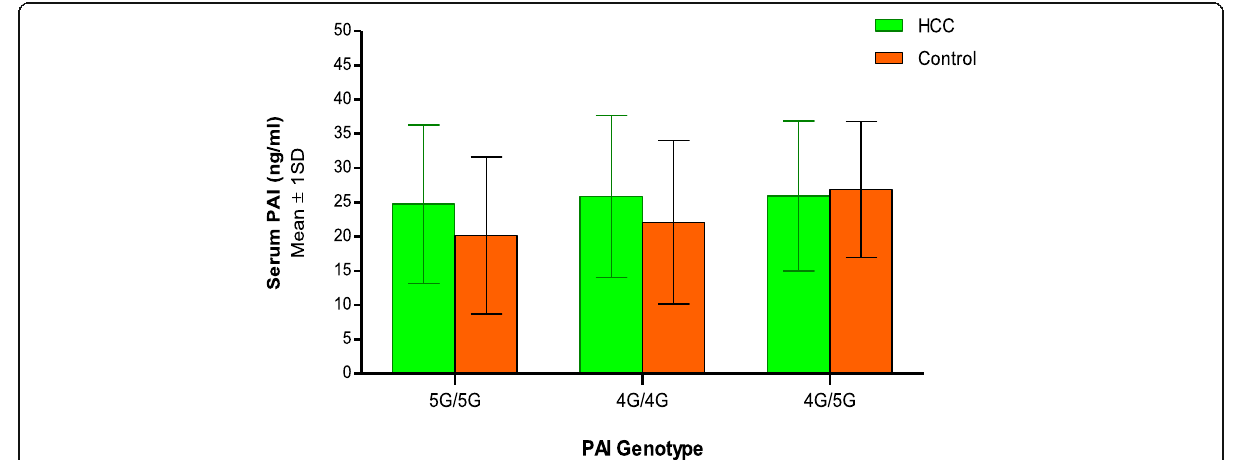
Fig. 1 The distribution of PAI-1 levels between patients, HCC, and control